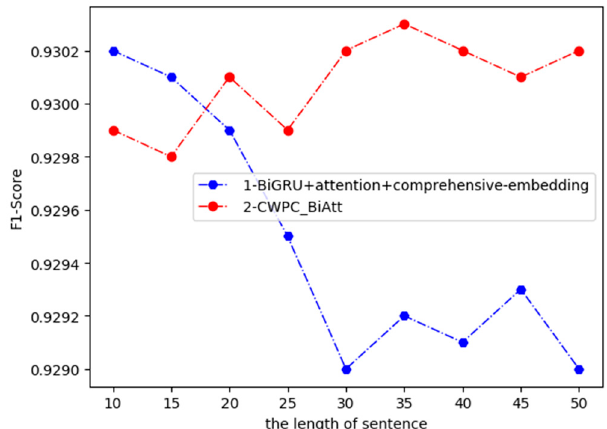
Figure 4. Experiments were performed on sentences of different lengths. As the sentence length increased, the results obtained by bidirectional gated recurrent unit (BiGRU) became worse, but its F-score was stable above 0.9090. Comprehensive-embedding carries sufficient information to make up for the shortcomings of BiGRU in processing long sentences. Our Character–Word–Position Combined bidirectional long short-term memory-attention (CWPC_BiAtt) model is very stable, and the F-score remains at 0.9298–0.9303.